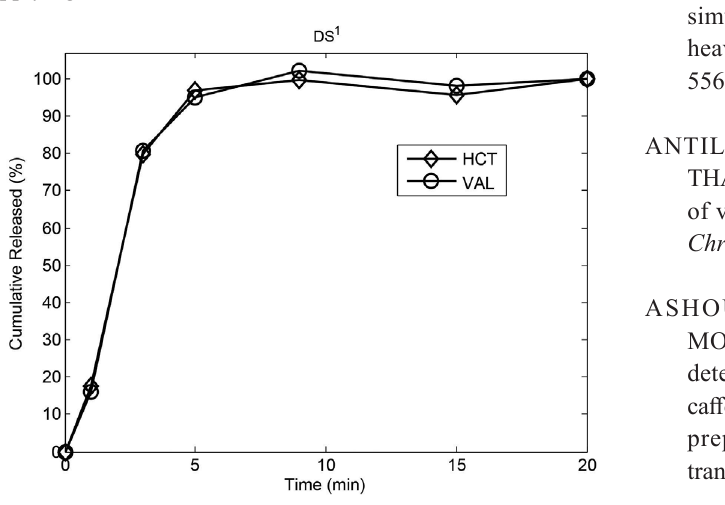
FIGURE 8 - Dissolution profiles of VAL and HCT obtained by applying first derivative